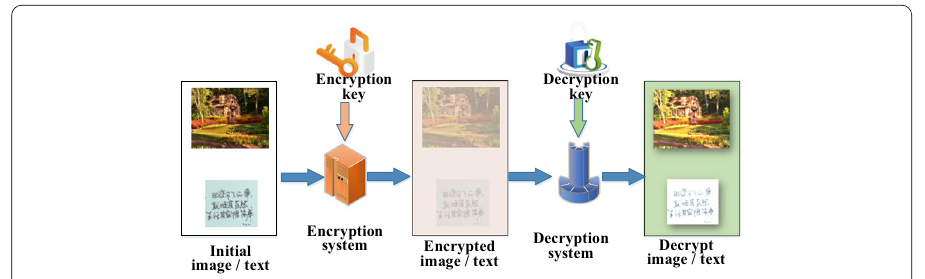
Fig. 1 Image text encryption and decryption